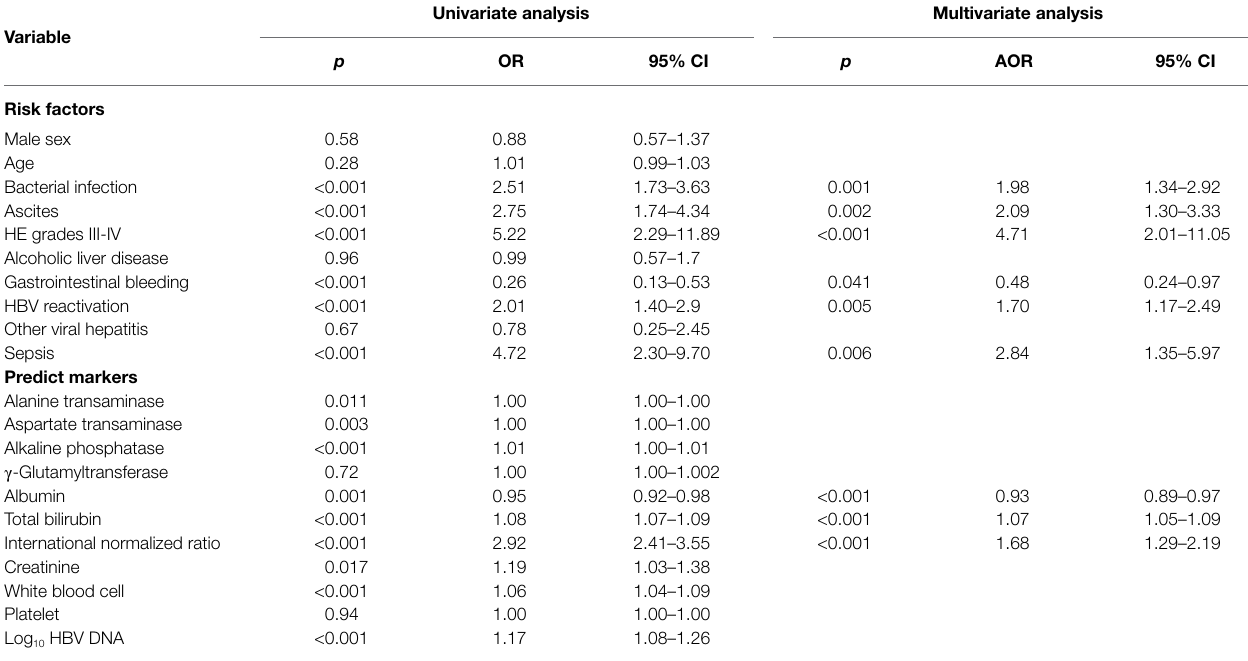
TABLE 2 | Univariate and multivariate analysis of the risk factors of the 90-day death in cirrhosis patients. Univariate analysis Multivariate Variable